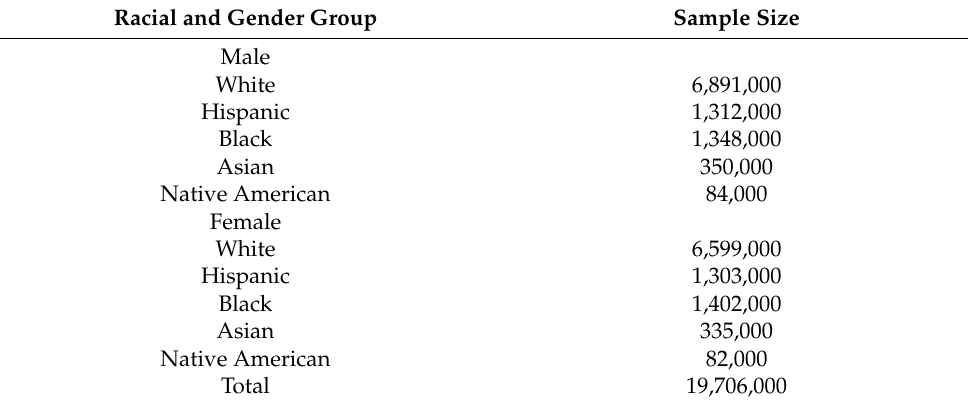
Table 1. Sample Sizes Used by Chetty et al.